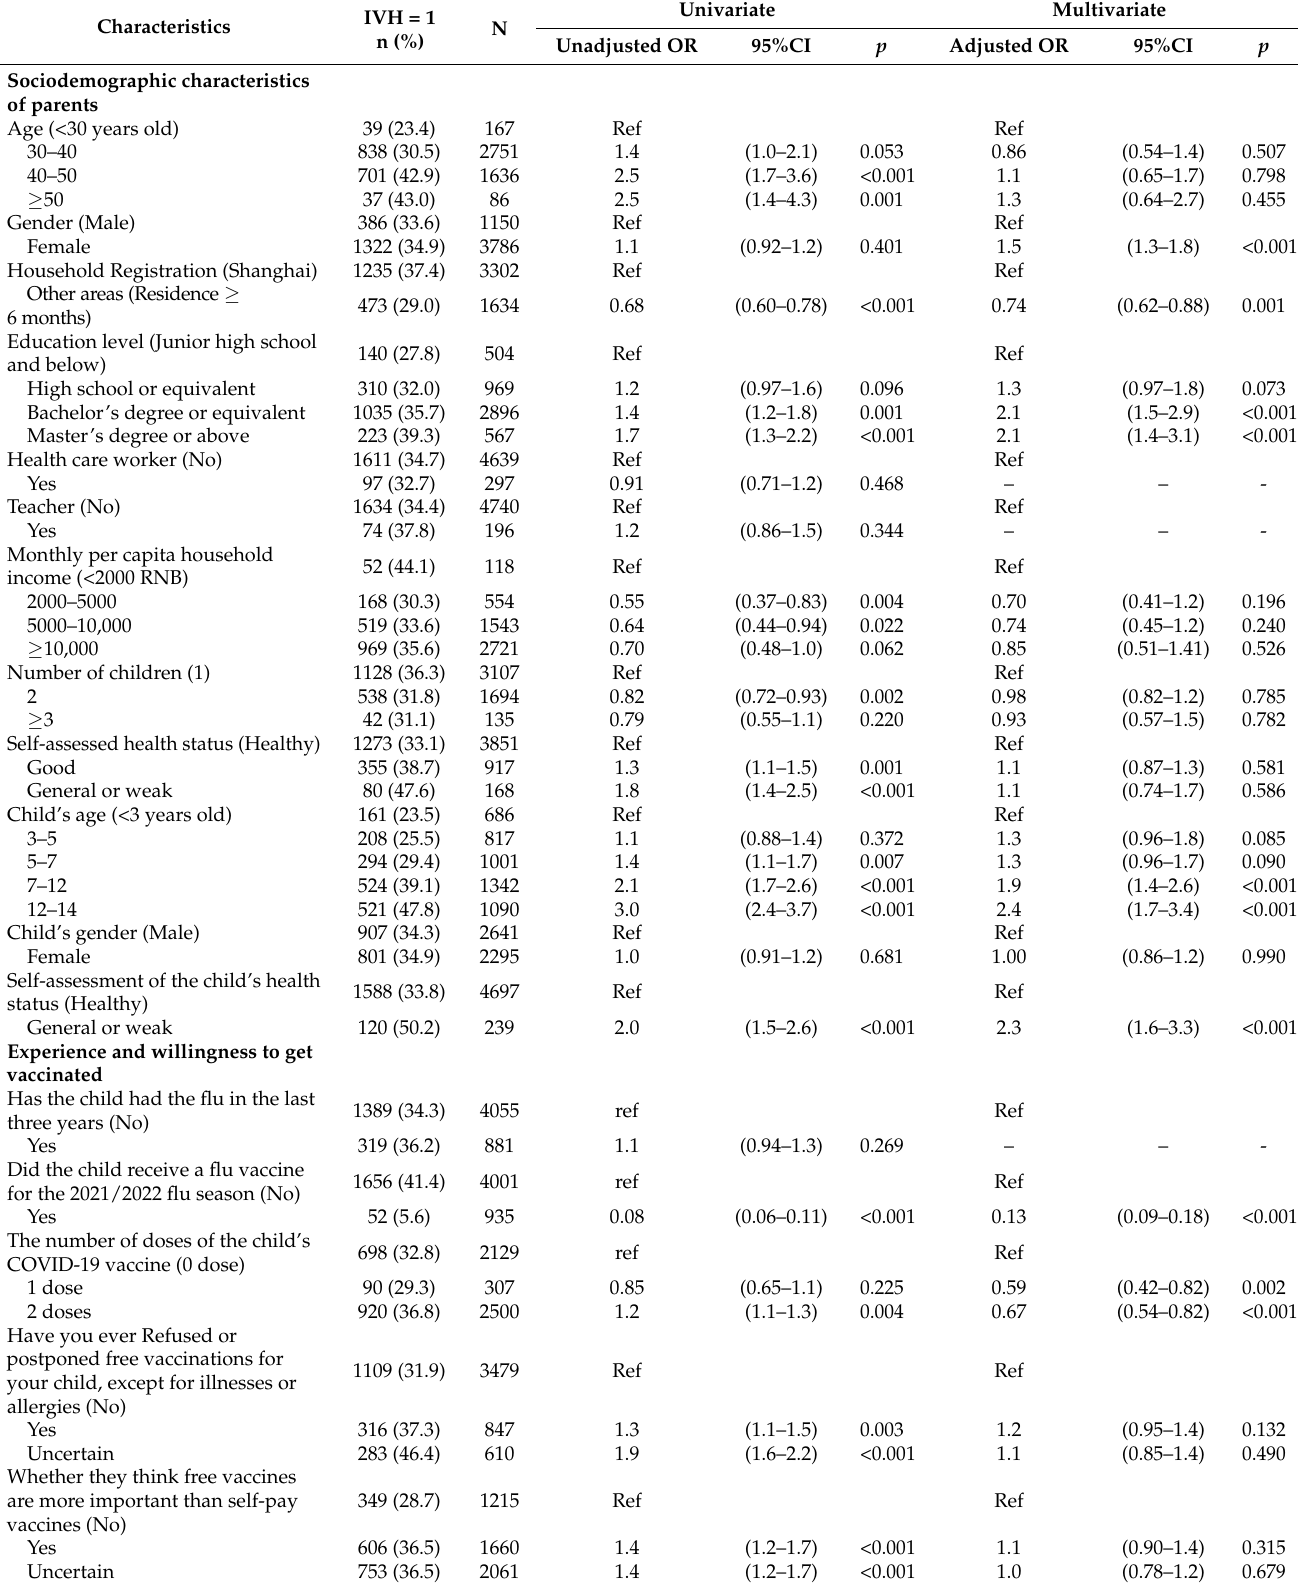
Table 3. Logistic regression analysis of predictors of parental